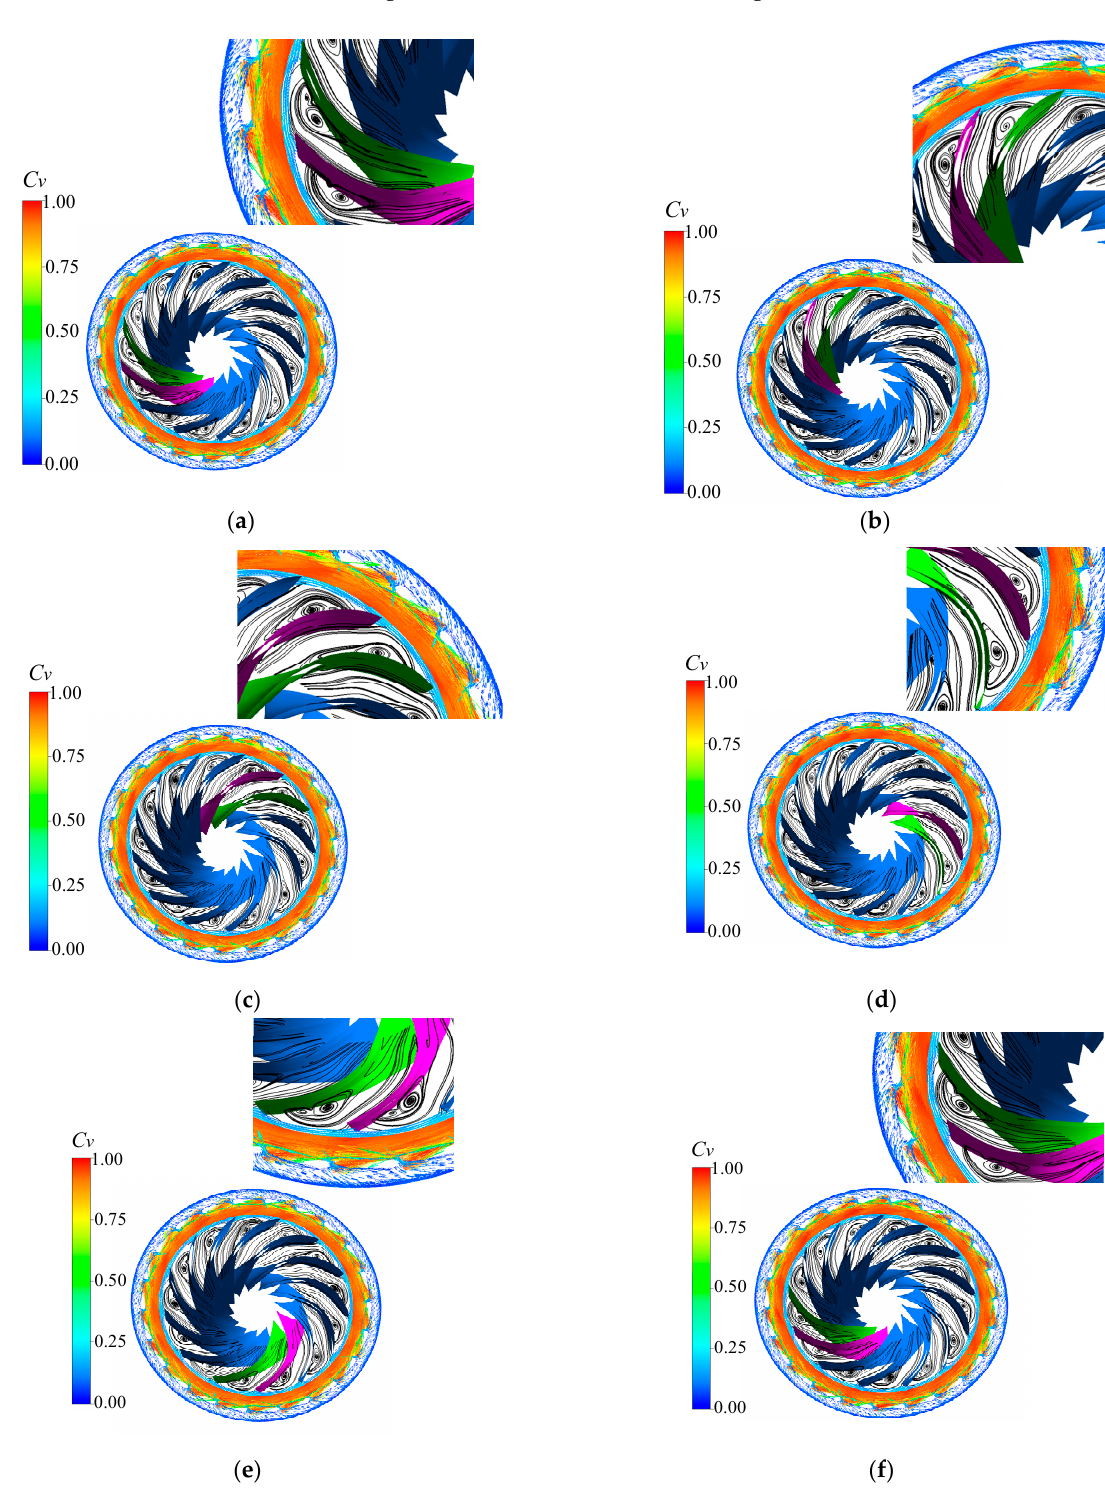
Figure 10. The internal flow characteristics of guide vanes and runners in one period. ( a ) 0 T ( b ) 0.2 T ( c ) 0.4 T ( d ) 0.6 T ( e ) 0.8 T ( f ) 1.0 T.